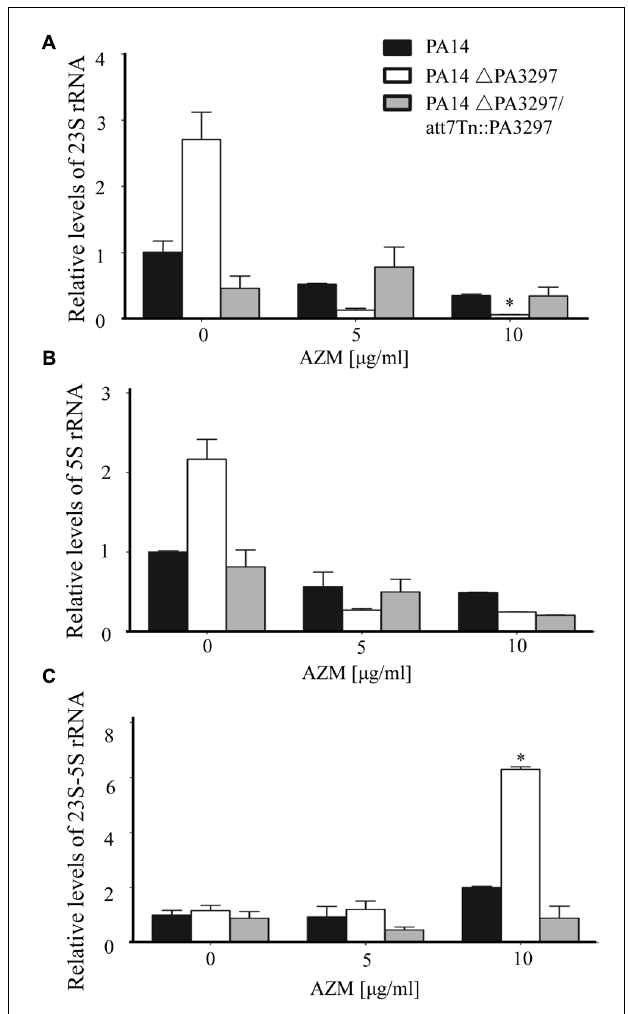
FIGURE 7 | Effects of AZM on the processing of rRNA. PA14, the (cid:49) PA3297 mutant and the complemented strain were grown at 37 ◦ C in the absence of AZM. When the OD 600 reached 0.3, AZM (0, 5, and 10 µ g/ml) was added. Total RNA was harvested when the OD 600 reached 2.0. The levels of total 23S (A) , 5S (B) , and unprocessed 23S-5S rRNA (C) were determined by real time PCR. The mRNA levels of PA1769 were used as an internal control. ∗ p < 0.05 compared to PA14 by student’s t